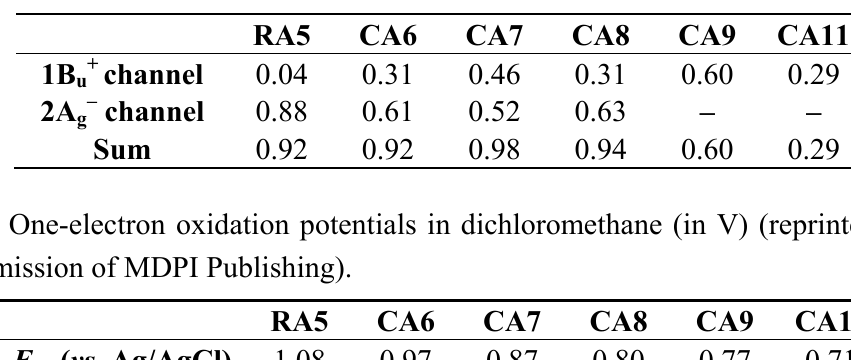
Table 1. Electron-injection efficiencies through the 1B u+ and the 2A g– channels and a sum of them, calculated by the use of time constants shown in Figure 5 (reprinted from [7] with permission of MDPI Publishing).